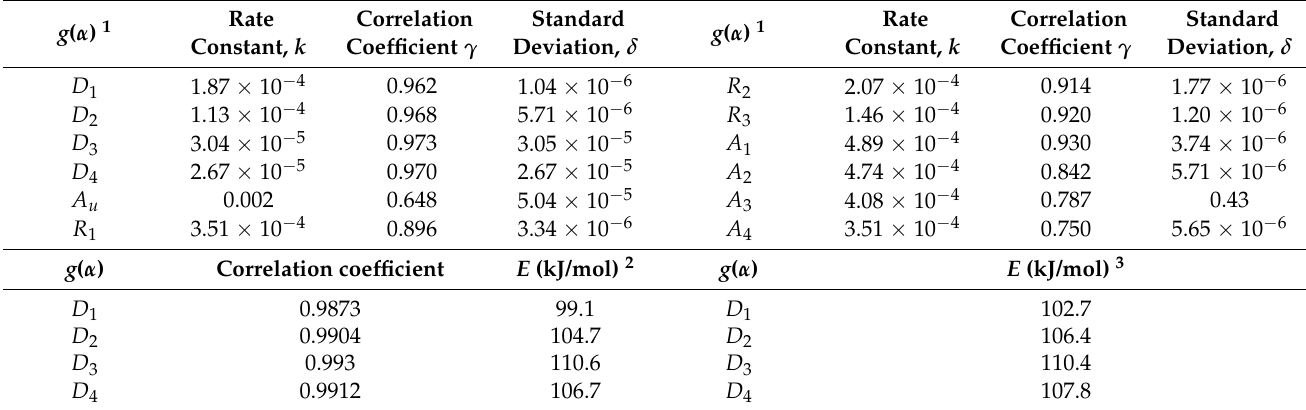
Table 1. Function analysis of solid-state thermal decomposition